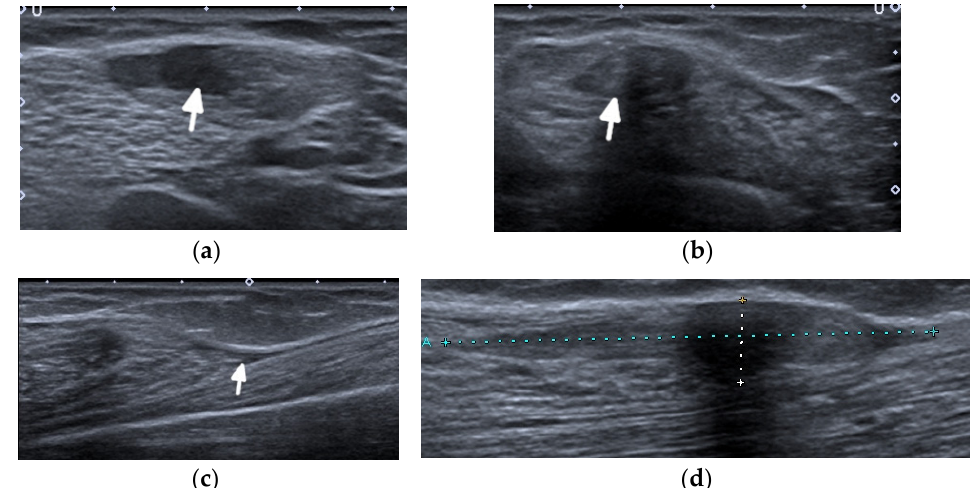
Figure 7. A complete tear of the proximal part of the bare tendon of the distal biceps brachii bilaterally in the same patient as in Figure 6. Short-axis ( a , b ) and long-axis ( c , d ) gray-scale ultrasound images of the bilateral elbow/distal arms show rupturing of the bilateral distal biceps tendons at the level of the myotendinous junction with hypoechoic proximal stums consistent with tendinopathy (arrows). In ( c , d ), note the retracted bilateral biceps muscles.